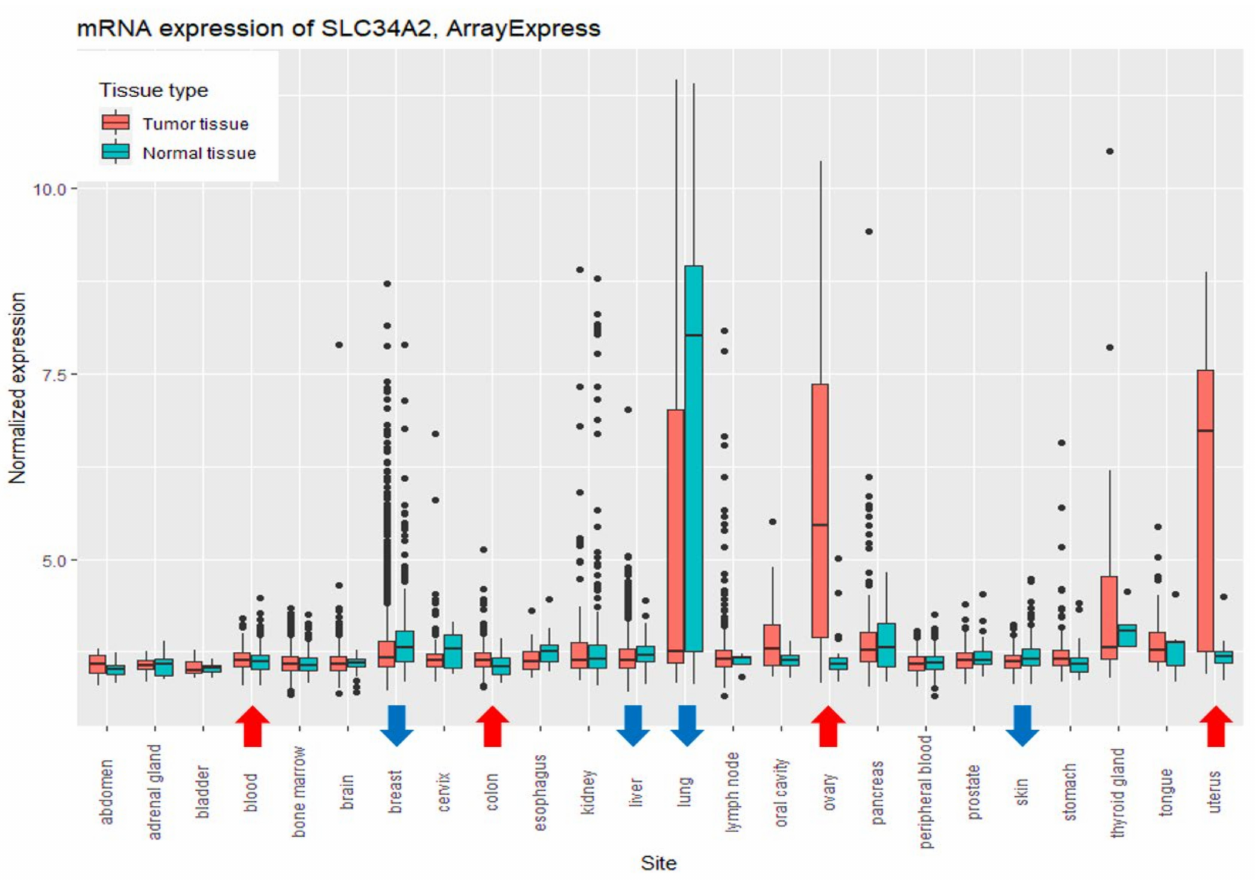
Figure 2. Comparison of the mRNA expression levels of SLC34A2 between relatively healthy and tumor tissues (ArrayEx- press: n = 12,873; Wilcoxon test, p <